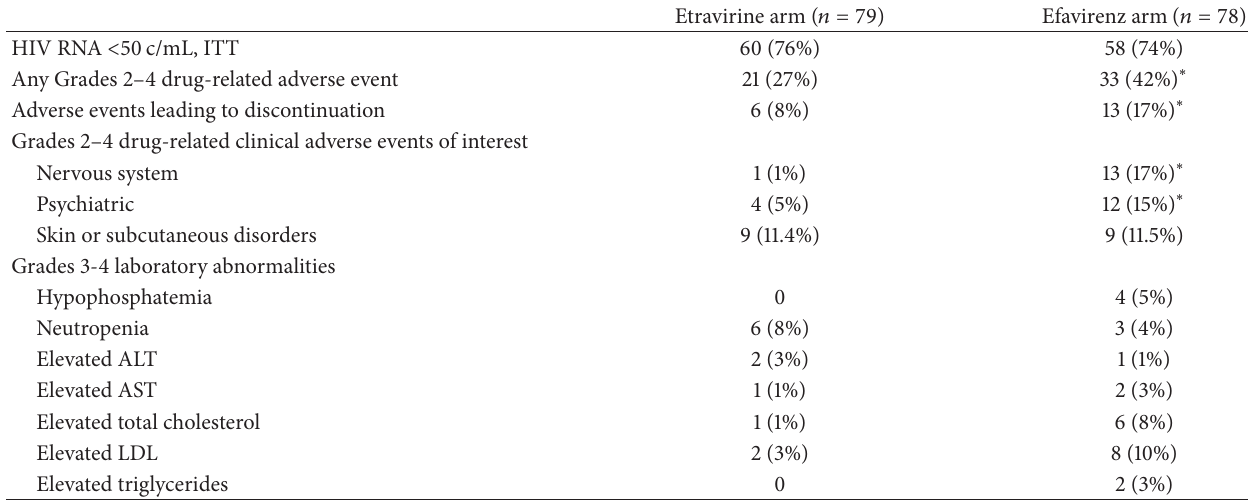
Table 3: SENSE trial: summary efficacy and safety results by treatment arm, to Week